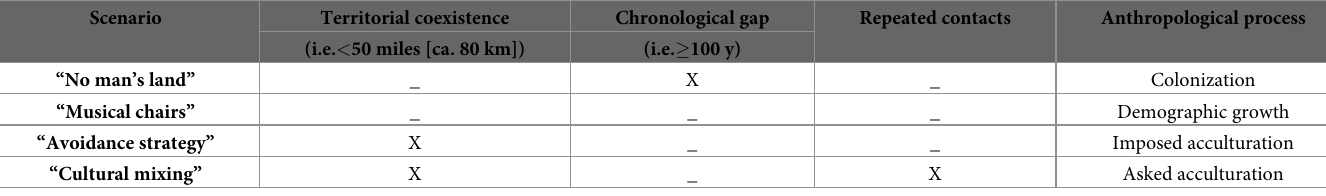
Fig 6. Example of a “musical chairs” scenario. Example of a “musical chairs” scenario: The last Mesolithic occupations disappeared less than 100 years before the first Neolithic settlements, or coexisted more than 50 miles (ca. 80 km) from each other, making the hypothesis of regular contact unlikely and suggesting rapid succession. Red dots: Neolithic occupations; blue triangles: Mesolithic occupations. Countries boundaries are from Natural Earth (free vector and raster map data @ naturalearthdata.com).